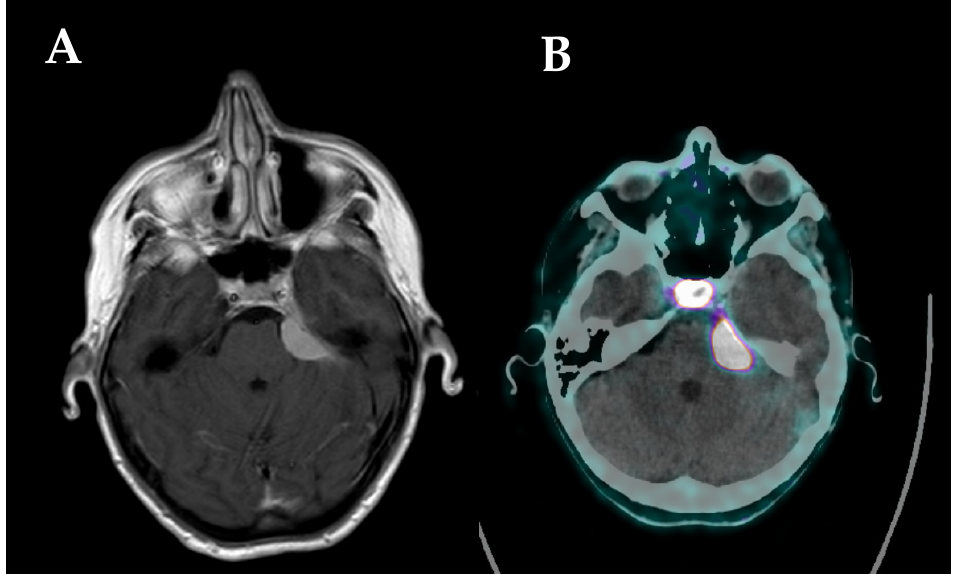
Figure 2. ( A ) MRI scan showing a left sphenopetrosal lesion suspected to be meningioma; ( B ) [ 68 Ga]Ga-DOTATOC PET/CT scan showing high tracer uptake of the left sphenopetrosal lesion, suggesting the diagnosis of meningioma, normal tracer uptake of the pituitary gland.